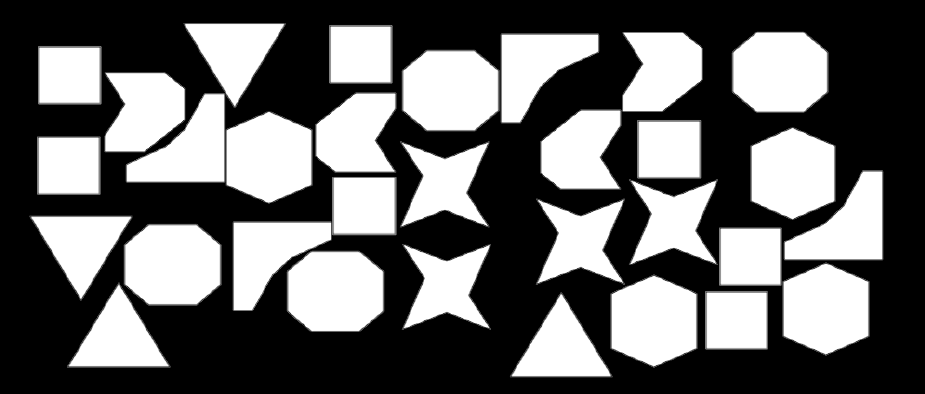
Figure 14. Solution found by the ILS algorithm inserting 31 pieces for the Shape 2 instance, consuming 2 h of processing time.